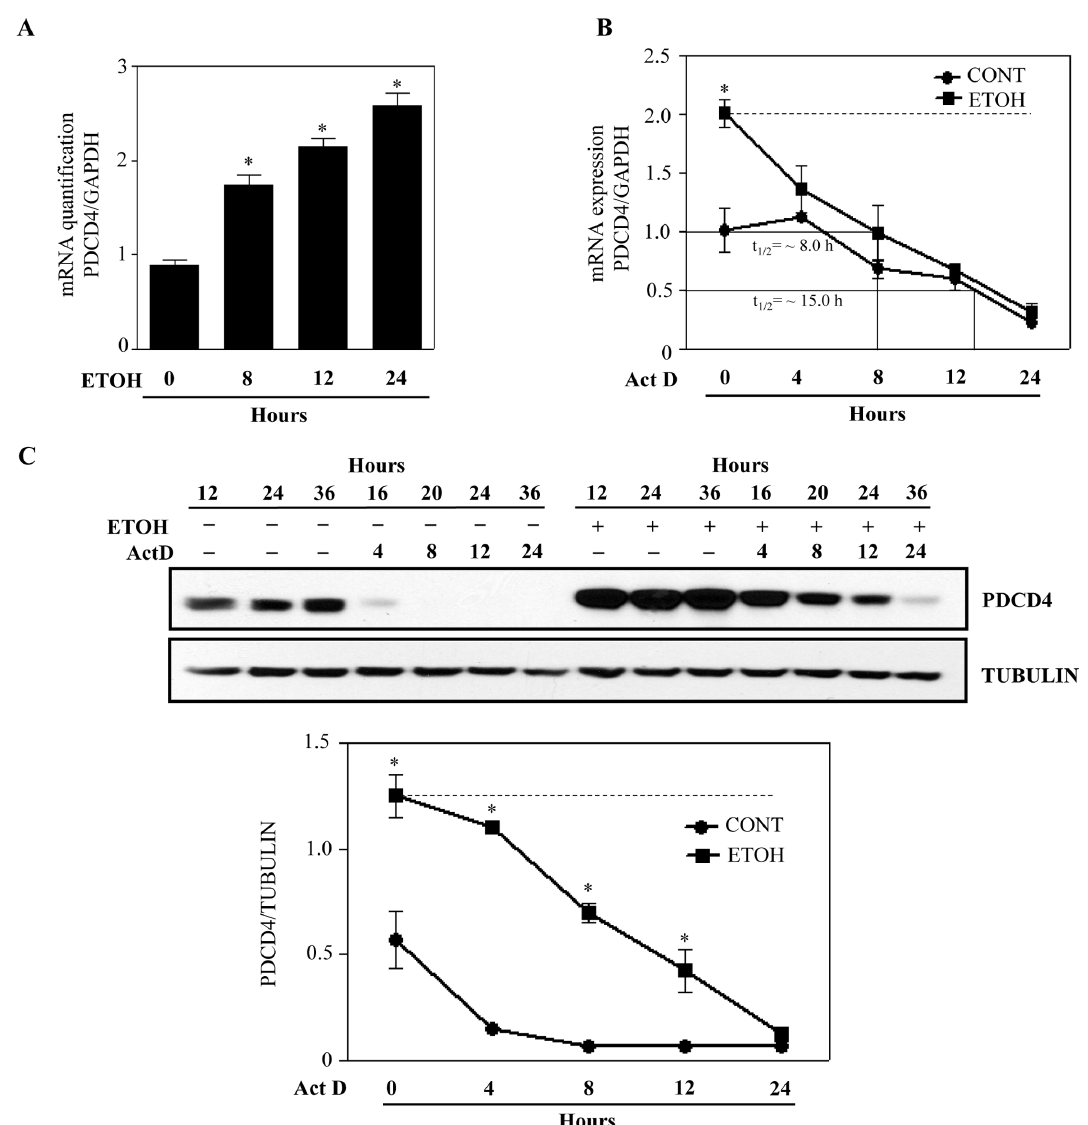
Figure 3. Ethanol exposure induces PDCD4 independent of mRNA stability in neuroblasts. ( A ) Quantitative real time PCR was performed on mRNA obtained from neuroblasts treated with or without ETOH (4 mg/ml) for indicated time periods. Pdcd4 expression was determined after normalizing to GAPDH mRNA expression. Statistical significance was established by one-way ANOVA and Newman-Keul’s posthoc test.*p , 0.05 when compared to control. ( B & C ) Cells were treated with or without 4 mg/ml of ETOH followed by Act D (1 m g/ul) treatment for indicated time periods (4, 8, 12 and 24 h) and cells were harvested at the end of the experiments for either PDCD4 or GAPDH mRNA analysis by qRT-PCR ( B ) or protein analysis by Western blotting ( C ). Statistical analysis was carried out by two-way analysis of variance (ANOVA) with Bonferroni post hoc tests.*p , 0.05 compared with control. n=3.